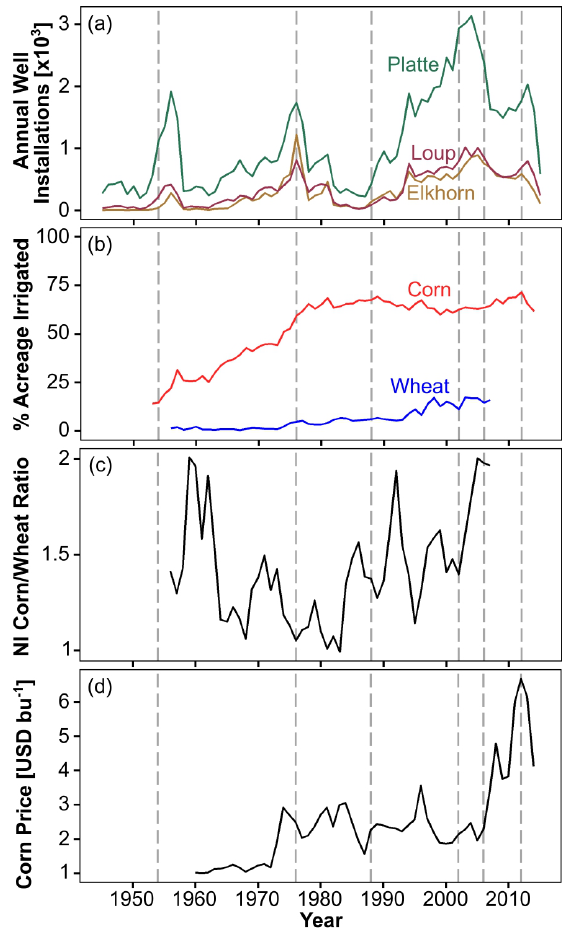
Fig. 3 . (a) Number of completed wells per year in each of the three study watersheds. (b) Proportion of total harvested acreage that is irrigated for both corn and wheat over time. (c) Ratio of corn to wheat planted on nonirrigated land over time. (d) Annual averaged corn price from the University of Illinois FarmDoc program (http://www.farmdoc.illinois.edu/). In each plot, dashed lines mark droughts in 1954, 1976, 1988, 2002, 2006, and